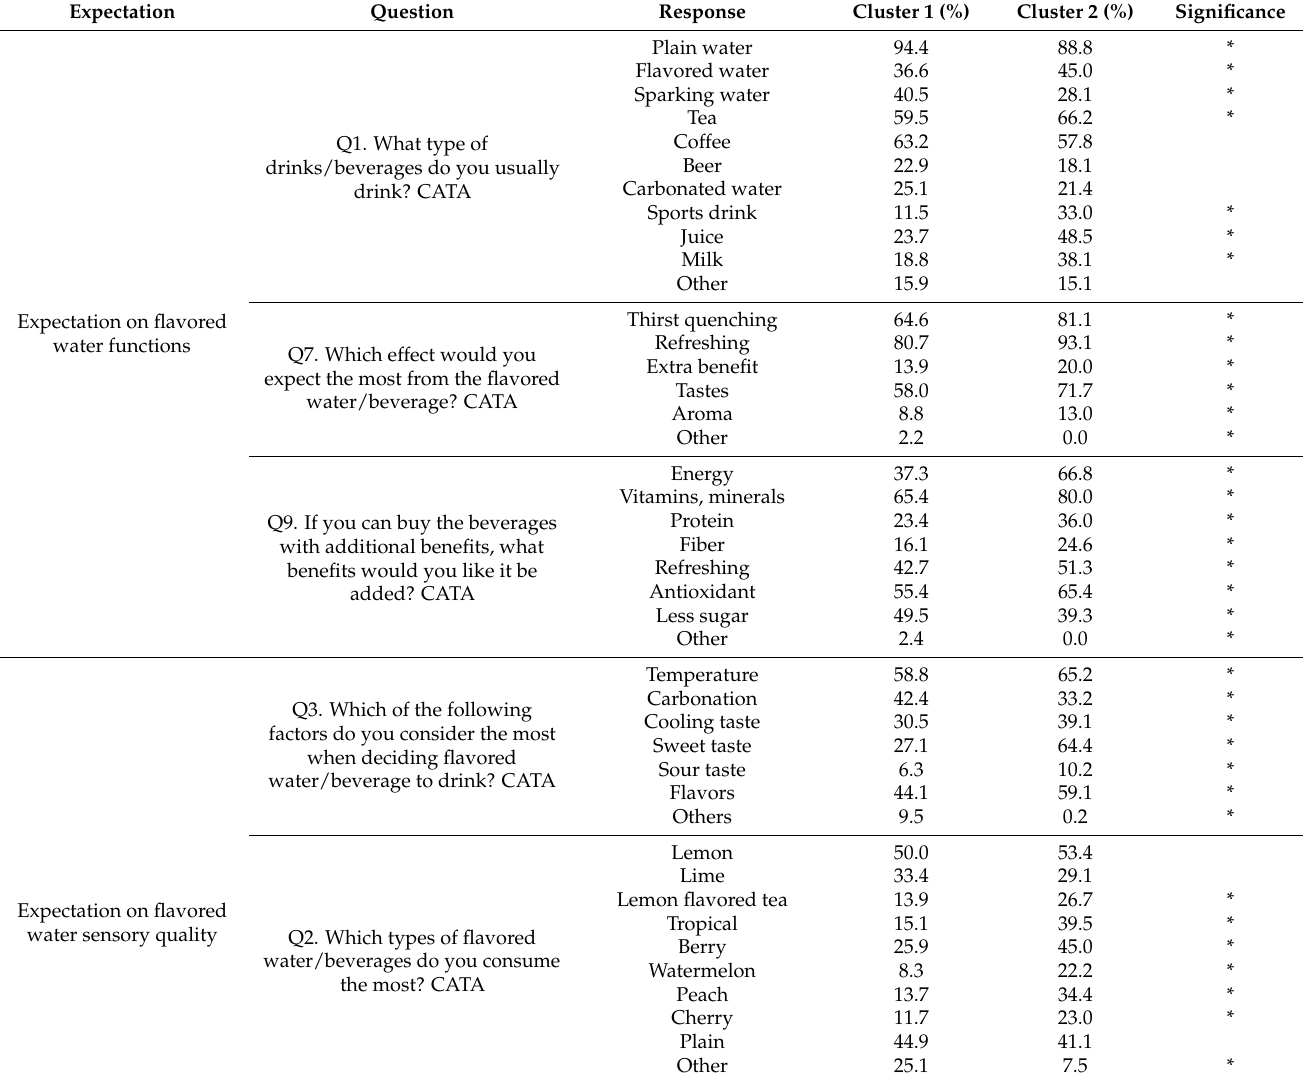
Table 1. Survey questions, responses, and percentages for survey questions distributed between two